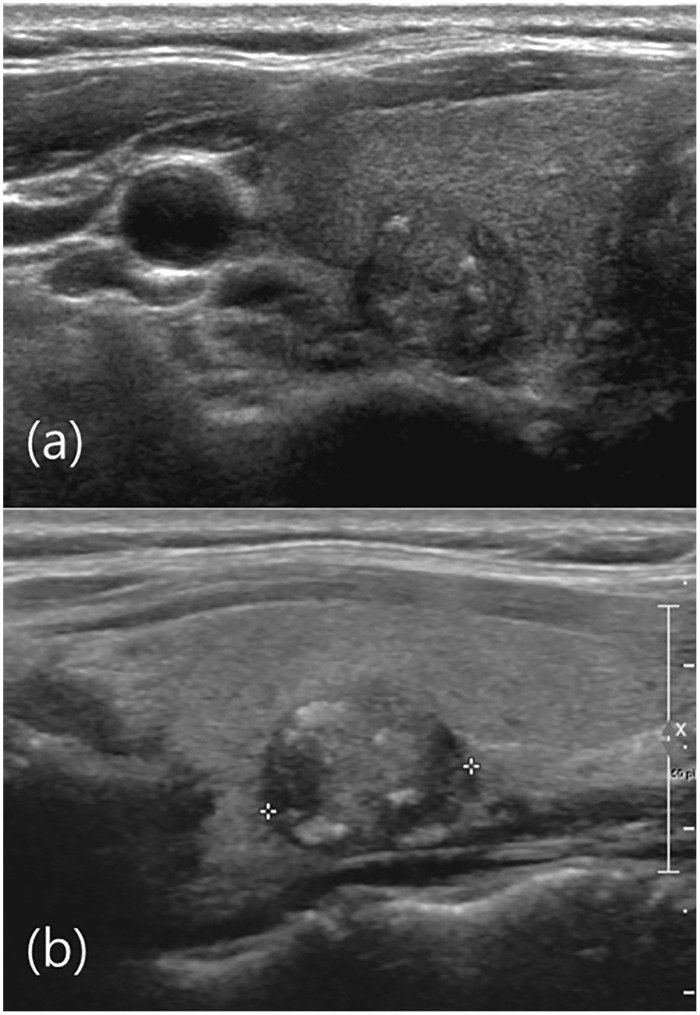
US image of right thyroid gland of a 46-year-old male.(a) Axial view show microlobulated isoechoic nodule with microcalcifications. (b) Sagittal view show a 1.3 cm microlobulated isoechoic nodule with microcalcifications (crosses) in the mid portion of the right thyroid gland. The US diagnosis was malignant and the FNA result was Bethesda category I (non-diagnostic). Total thyroidectomy was performed and the pathological result was papillary thyroid cancer. US was highly sensitive in identifying nodules diagnosed as Bethesda category I.